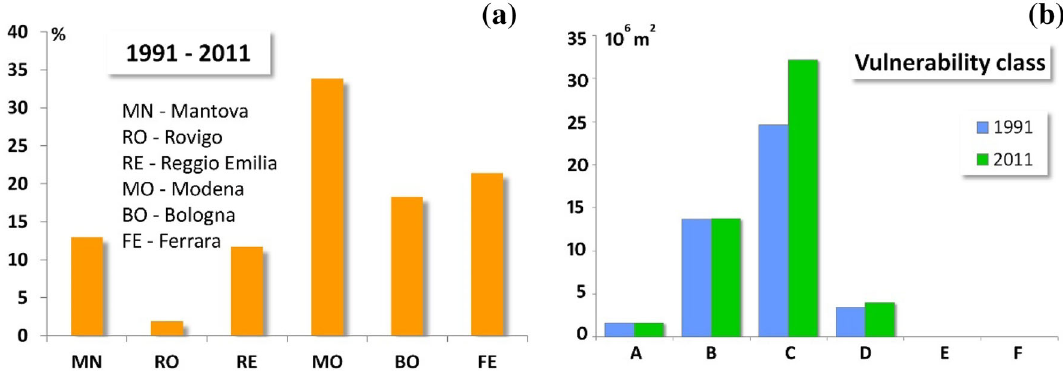
Fig. 2 Variation of building consistency between 1991 and 2011. a Percentage increase of the building stock in the last two decades related to 88 municipalities hit by the May 2012 earthquake sequence, grouped into provincial administrations. b Vulnerability distribution